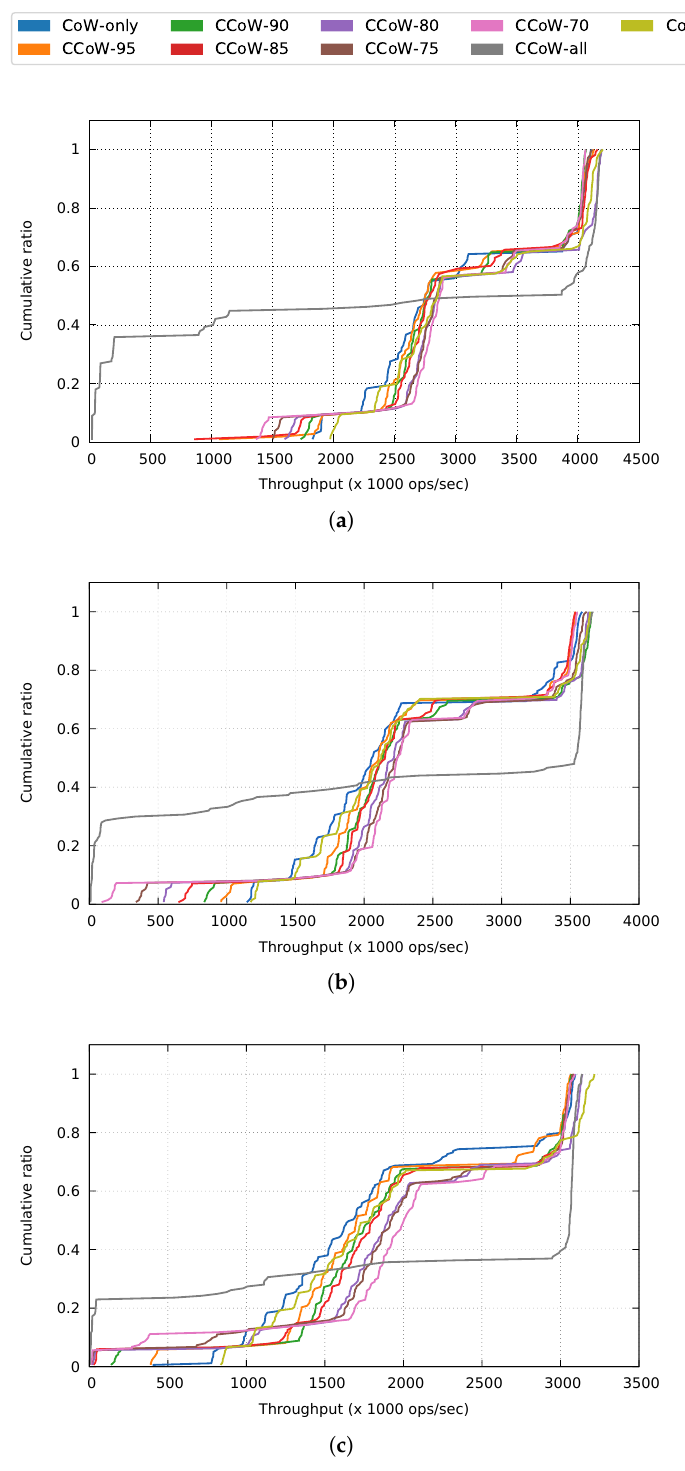
Figure 6. Cumulative distribution of the throughput during the evaluation. ( a ) High-locality workload ( α = 1.1). ( b ) Baseline ( α = 1.0). ( c ) Low-locality workload ( α =